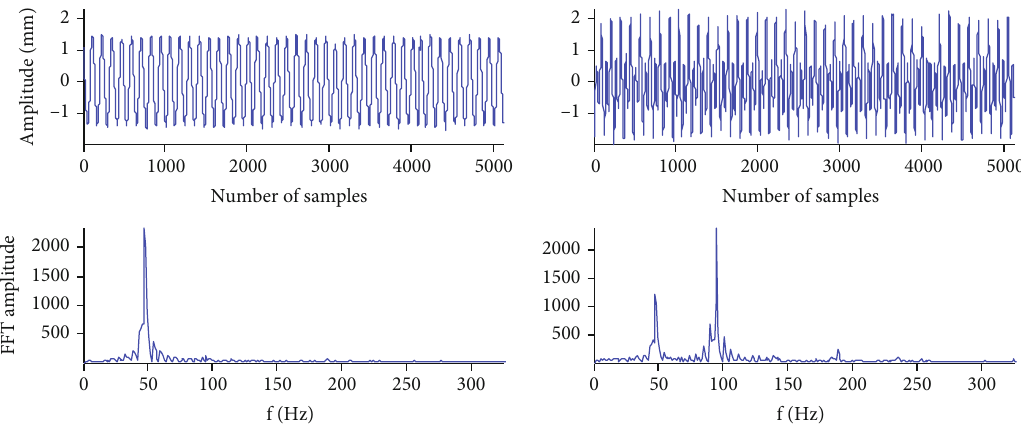
Figure 11: Time – frequency waveforms of rotor coupling fault vibration signals by the WPA-FastICA